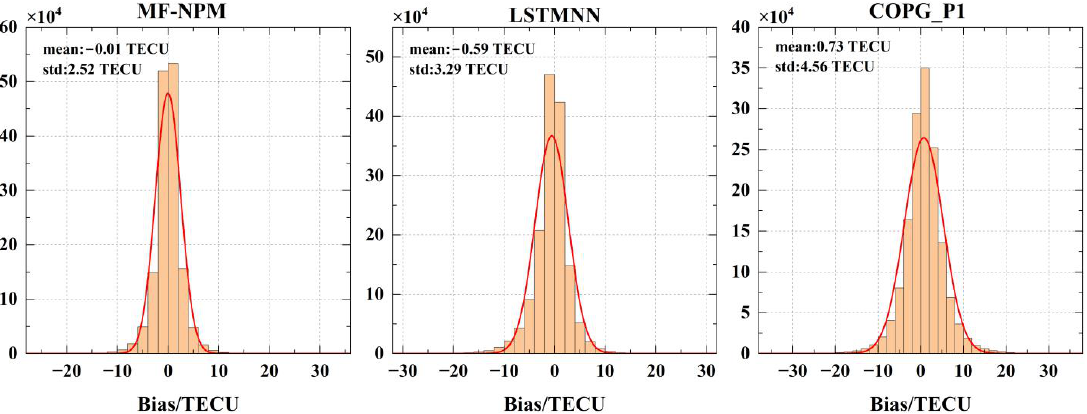
Figure 3. Histogram for MF-NPM, LSTMNN, and COPG_P1 with reference to IGS GIM in the peak year of solar activity (2014). Table 3. Percentage of bias for MF-NPM, LSTMNN, and COPG_P1 in the peak year of solar activity (2014).